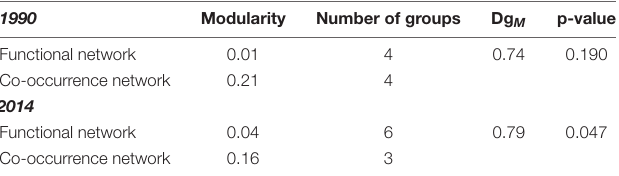
TABLE 6 | Modularity of the different networks and module diversity (Dg M ) for 1990 and